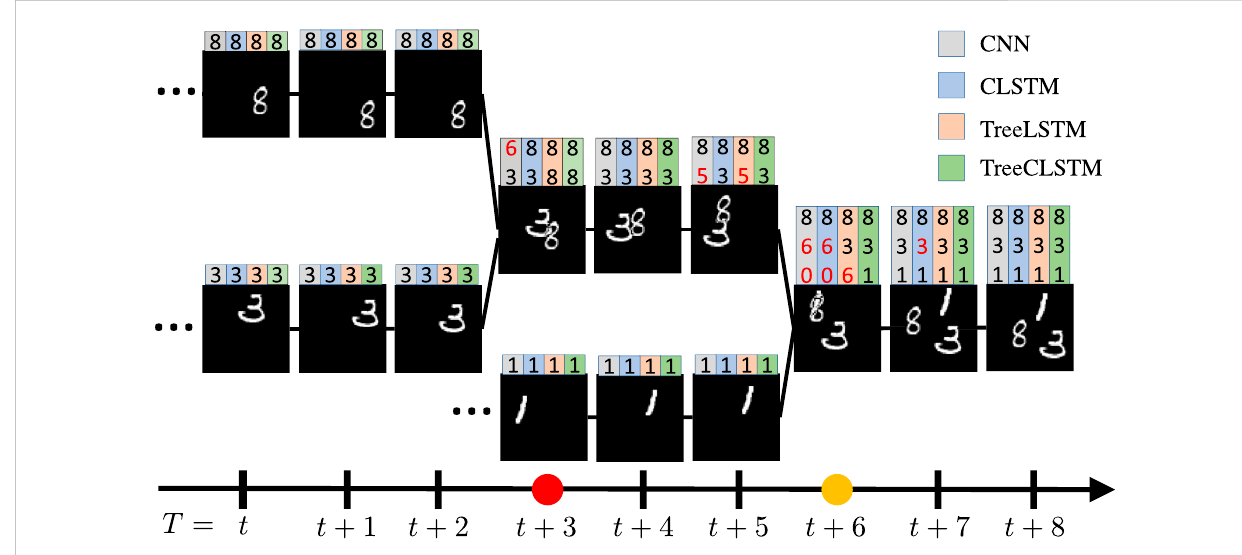
FIGURE 3 OneexamplefromTree-Moving-MNIST withthreedigitsboundinginsidea64×64 patchfromtime T = t to T = t +8.Onthetopofeachnodeshows the prediction results of CNN in gray color, sequential ConvLSTM (CLSTM) in blue color, fully connected tree-structured LSTM (TreeLSTM) in orange color, and tree-structured ConvLSTM (TreeCLSTM) in green color, respectively. The digits in red color denote wrong predictions. Note that all methods, except TreeCLSTM, has false predictions to certain extent. The red and yellow dots on the time axis (bottom) denote the timestep that the digits merge with others. Note that CNN, CLSTM, TreeLSTM, and TreeCLSTM tend to make false predictions at these timesteps because of their weak capabilities to model the inter-node dependencies among the tree